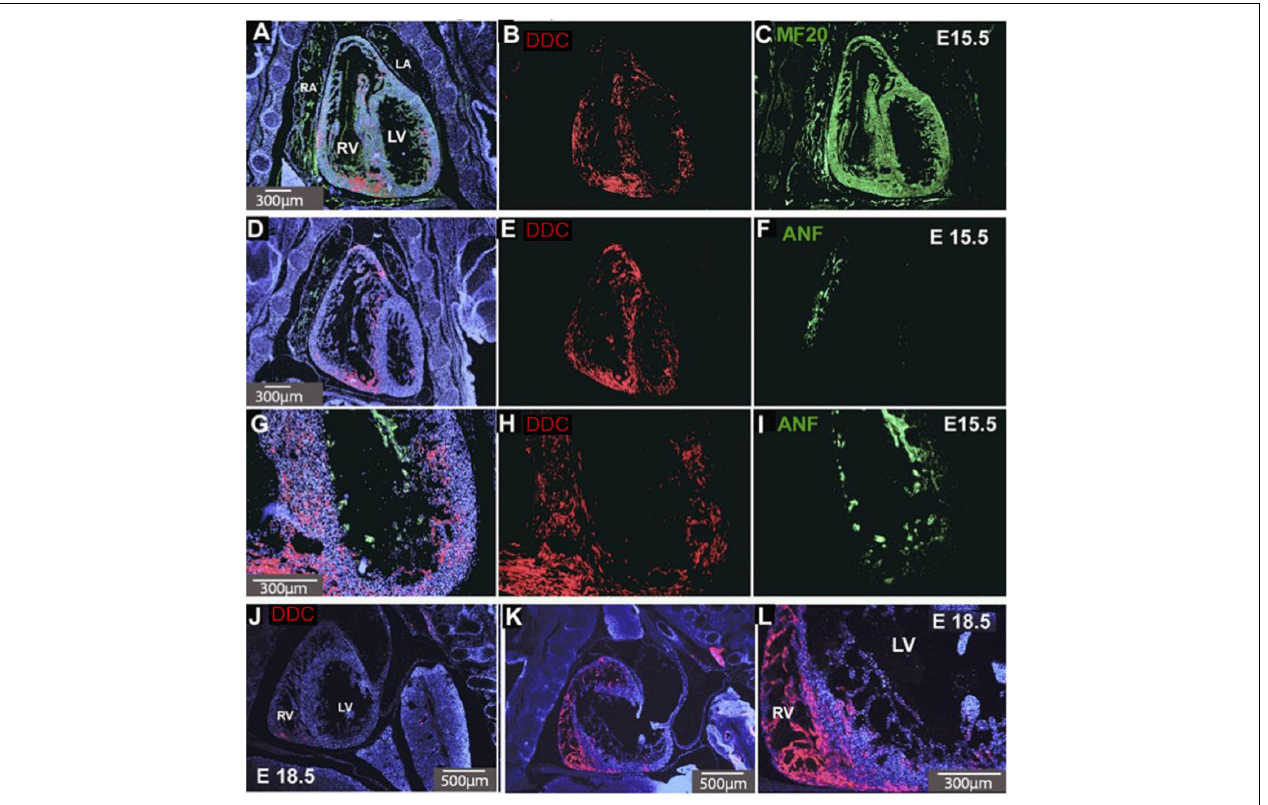
FIGURE 1 | DDC in E15.5 and E18.5 hearts. Coronal sections of the heart co-stained for DDC (red) and the myocardial marker MF-20 (green) (A–C) and DDC and a marker of trabeculae, ANF (green) (D–I) . DDC protein (red) is present throughout the ventricular myocardium and interventricular septum (IVS), the structure separating the right and left ventricles, (B,E,H) , but absent from the atria and the trabecular layer, except where the trabeculae meet the compact myocardial layer (D–I) . This is also seen in sagittal sections at E18.5 (J–L) where DDC is present in the myocardium, IVS, and right ventricular myocardium. Blue staining is DAPI nuclear counterstain (A,D,G,J,K,L) . RV Right Ventricle, LV Left Ventricle, RA Right Atrium, LA Left Atrium. Minimum number of hearts examined =